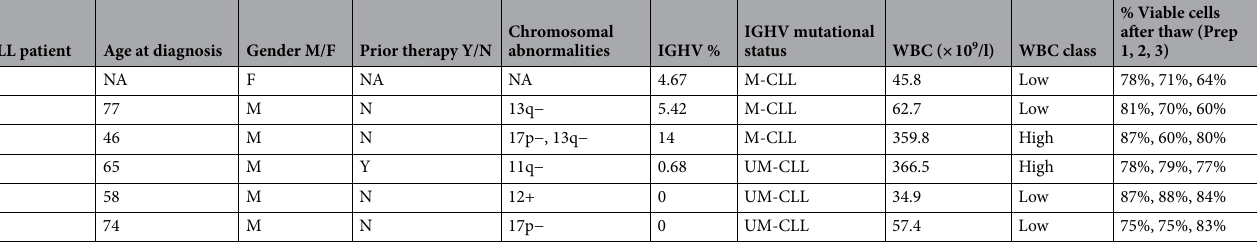
Table 1. Clinical features of CLL samples analysed by SWATH-MS to identify variation in proteomics data associated with biological and technical factors. IGHV refers to somatic mutation in the IGHV gene of CLL cells compared with the gene sequence of the nearest germ line, where < 2% was classed as UM-CLL and > 2% was classed as M-CLL. WBC refers to the white blood count of the patient at time of sampling. > 300 × 10 9 /l was classed as high WBC and < 100 × 10 9 /l was classed as low WBC in this cohort. Prior therapy consisted of various combinations of glucocorticoid, chlorambucil, fludarabine, or fludarabine plus cyclophosphamide. CLL samples were tested by interphase fluorescence in situ hybridization for del17p13 (17p−), del11q23 (11q−), trisomy 12 (12+, and del13q14 (13q−). 17p and 11q- are regarded as high-risk chromosomal abnormalities.